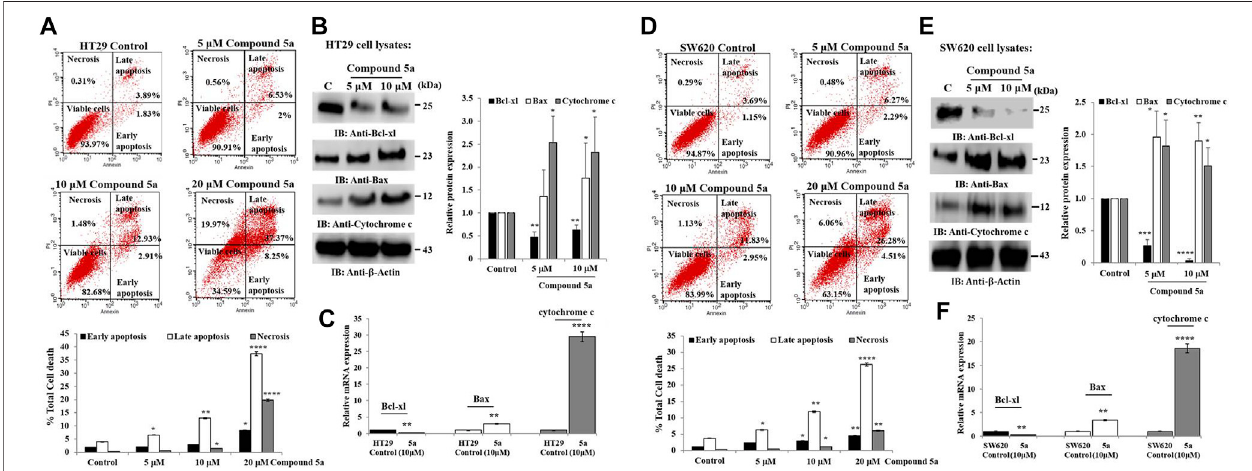
FIGURE5| Compounds5aexertspro-apoptoticeffectsassociatedwithBcl-xldownregulationandBaxandcytochromecupregulationinHT29andSW620cells. Representative scatter plots of apoptotic status determination in HT29 (A) and SW620 (D) using fl ow cytometry after Annexin V-FITC/PI-PE double staining. Early and late apoptotic cells are Annexin V+/PI- and Annexin V+/PI+, respectively. Necrotic cells are Annexin+/PI+ and viable cells, Annexin-/PI-. The bar graph depicts the percentage of total cell death, including early, late apoptotic, and necrotic cells. Data are shown as mean ± SD ( n = 3). Total HT29 (B) and SW620 (E) cell lysates were immunoblotted against Bcl-xl, Bax, and cytochrome c using their speci fi c monoclonal antibodies. Bar graph indicating the relative Bcl-xl, Bax, and cytochrome c protein expression level, related to the loading control ß -actin. Bar graph showing the relative mRNA expression level of Bcl-xl, Bax, and cytochrome c in HT29 (C) and SW620 (F) RNAextractsrelated totheinternalcontrolGAPDH.Dataareshown asmean±SD( n =3).* p < 0.05,** p < 0.01,*** p < 0.001,and**** p < 0.0001 vs